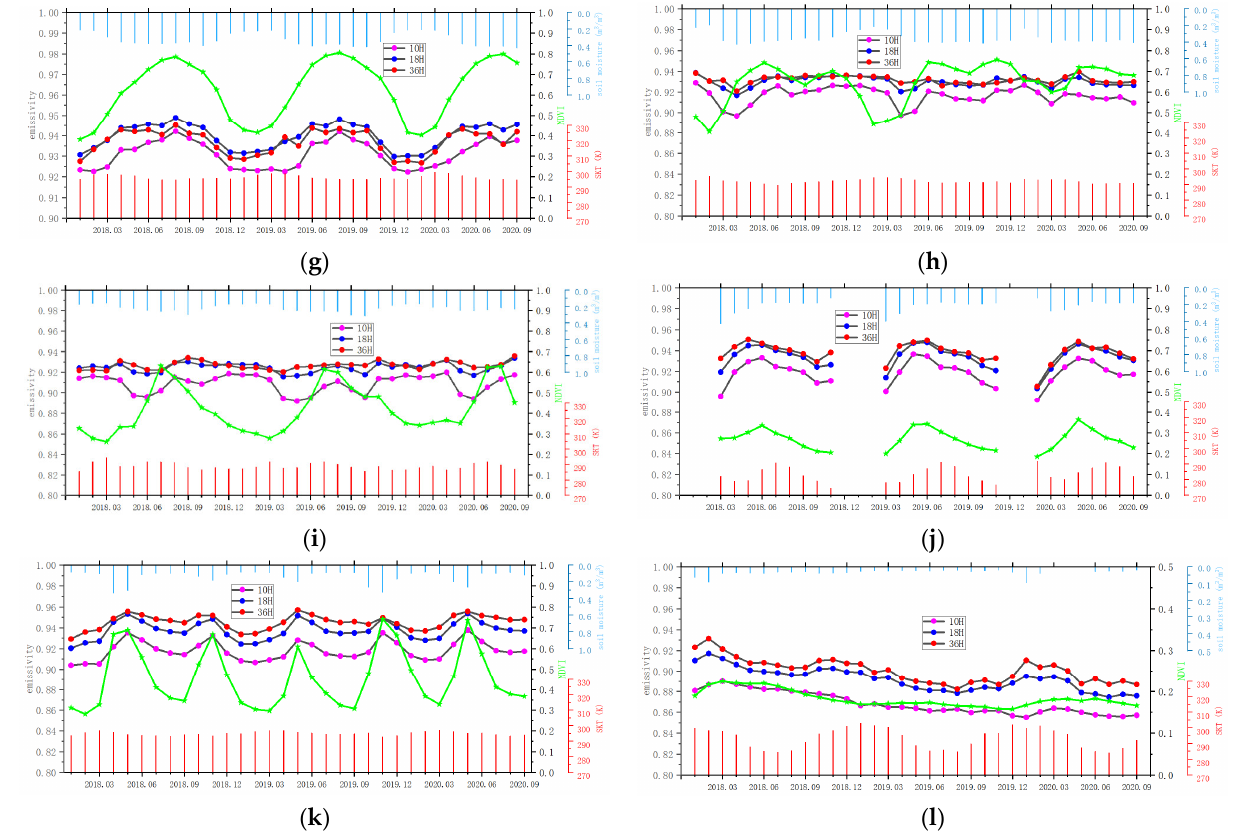
Figure 4. The temporal variations in monthly mean emissivity of 10H, 18H and 36H for 12 vegetation types, time ranging from January 2018 to September 2020. ( a ) deciduous needleleaf forests; ( b ) evergreen needleleaf forests; ( c ) mixed forests; ( d ) deciduous broadleaf forests; ( e ) evergreen broadleaf forests; ( f ) woody savannas; ( g ) savannas; ( h ) cropland/natural vegetation mosaics; ( i ) croplands; ( j ) grasslands; ( k ) closed shrublands; ( l ) open shrublands.